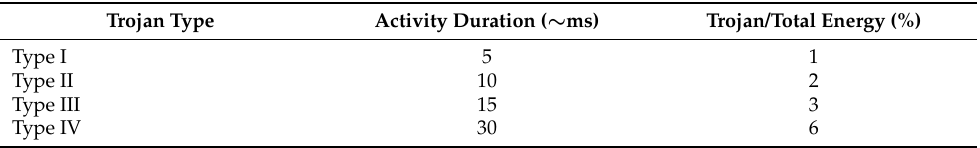
Table 1. Types of